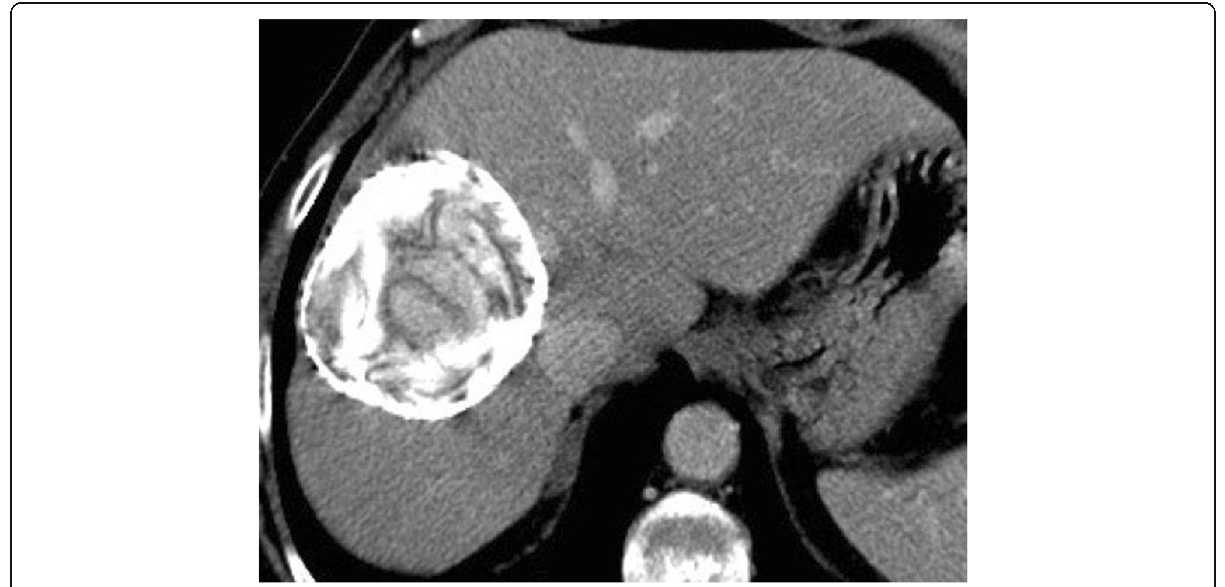
Fig. 2 A 65-year-old woman with contained rupture hydatid cyst due to response to therapy. Contrast-enhanced CT on portal venous phase shows the serpentine linear membrane within an almost completely calcified